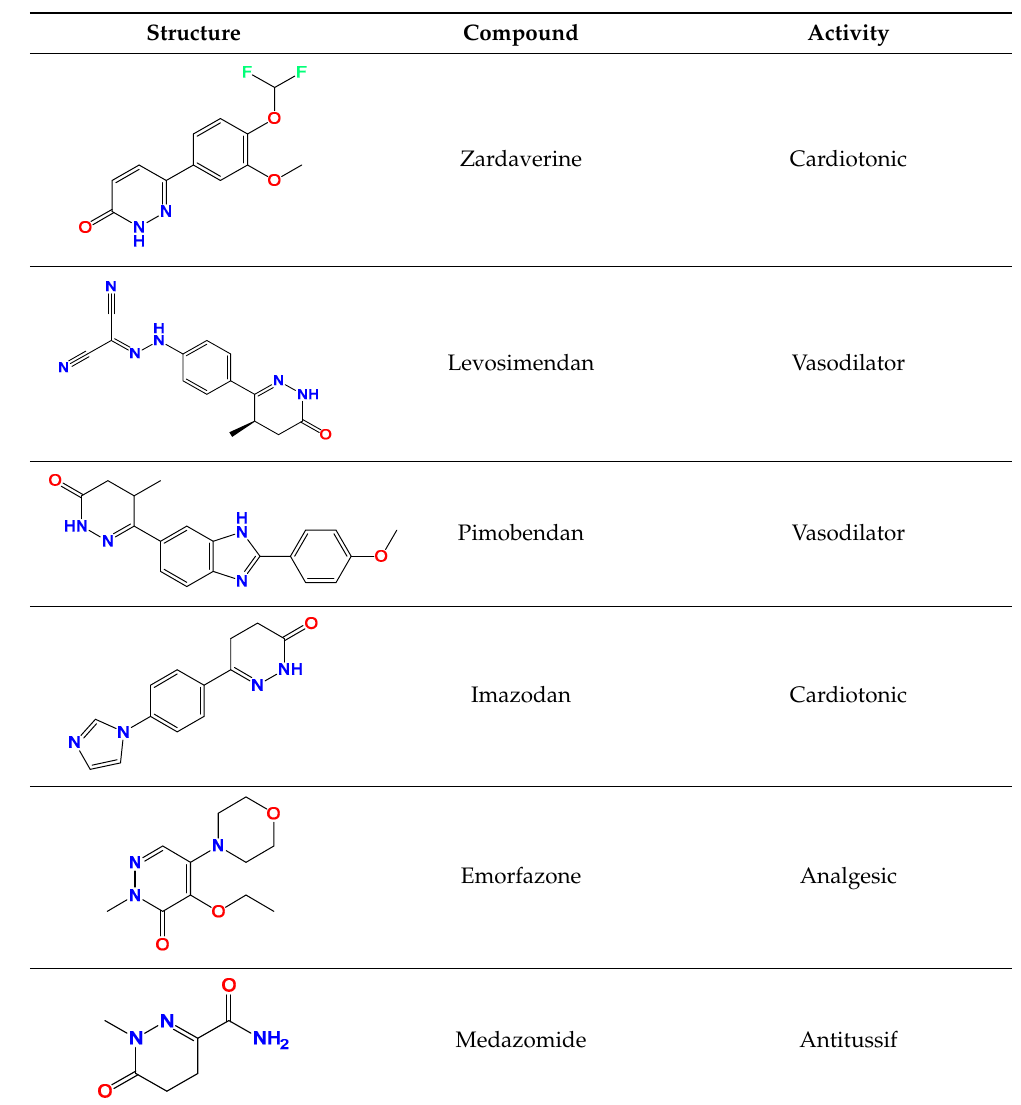
Table 1. Some therapeutic drugs with pyridazinone core.